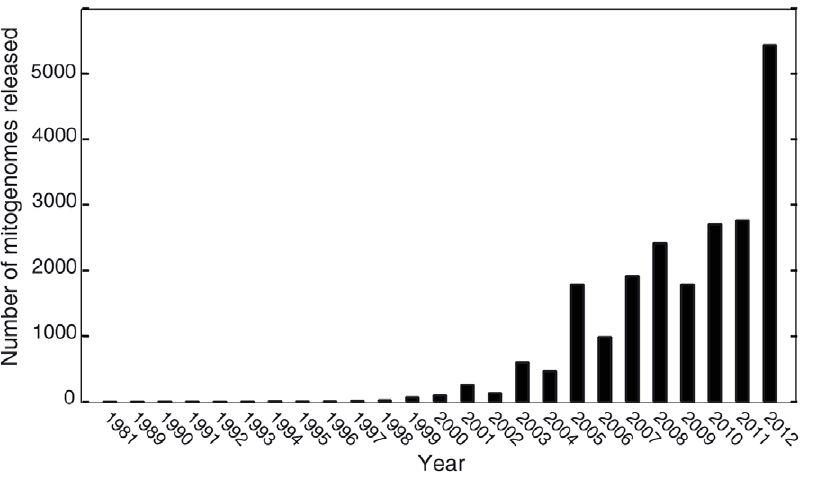
Figure 1. Release of mitogenome sequences in GenBank. The number of released mitogenomes has been plotted against the year of release (2012 covers only the first 9 month of the year, until the date of analysis).